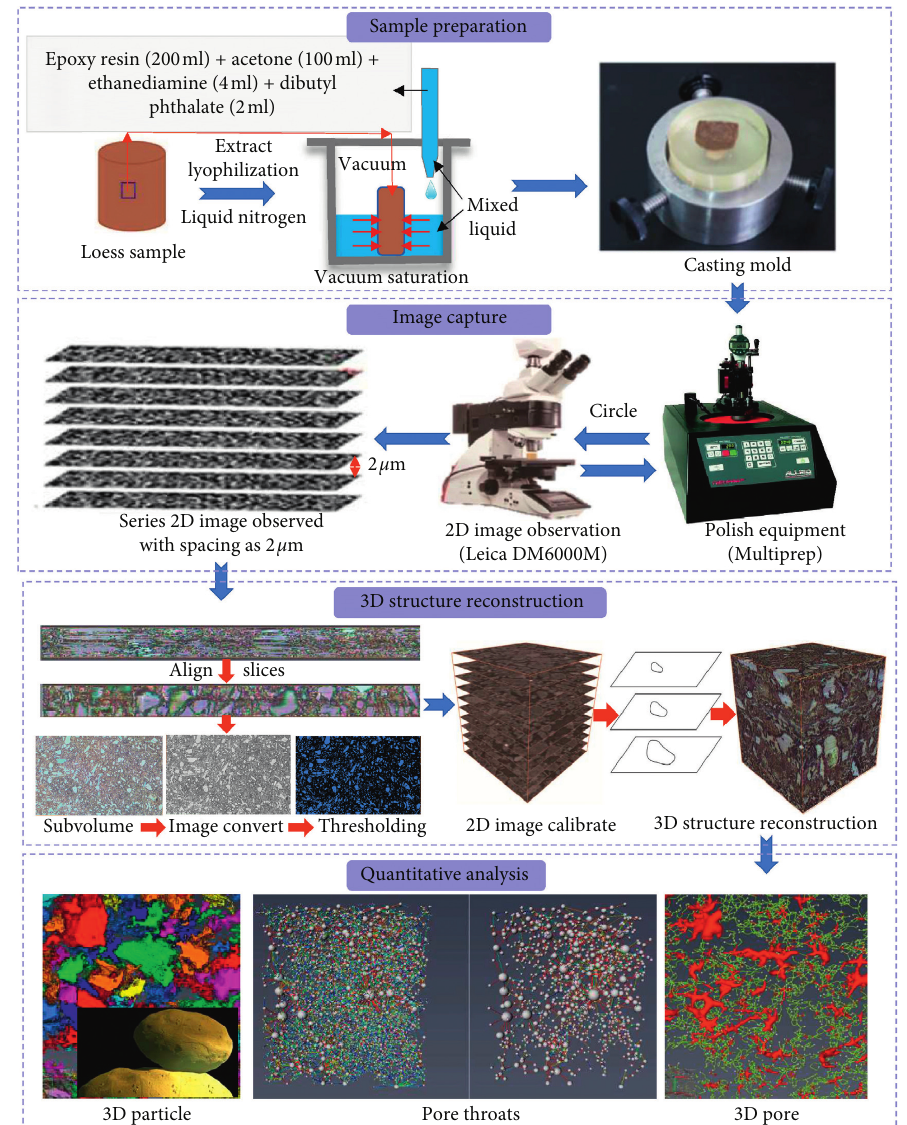
Figure 2: The experiment and image reconstruction process.